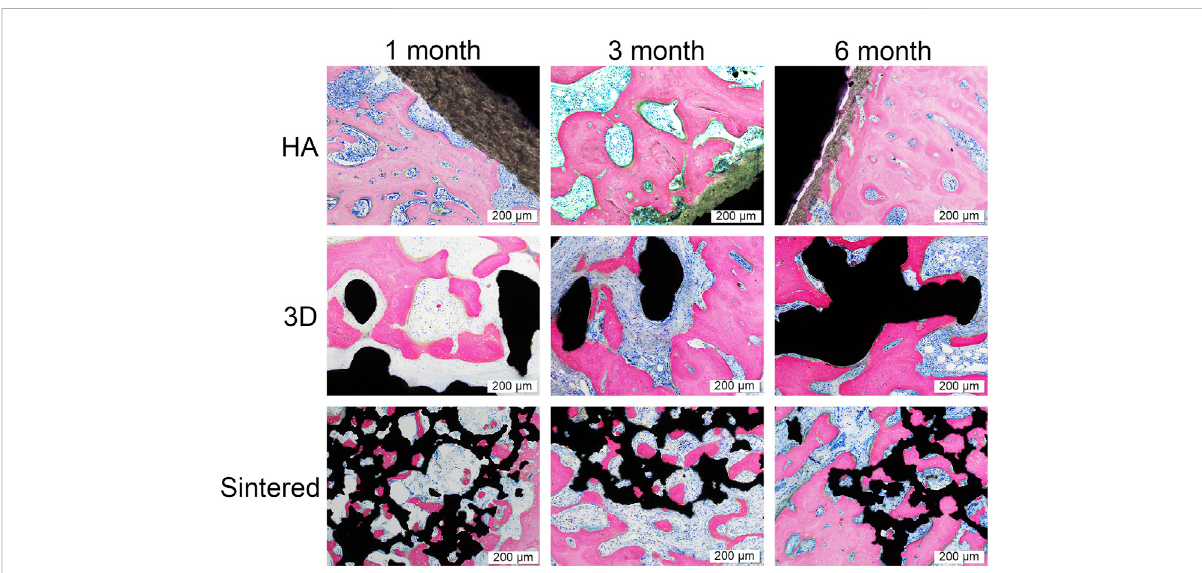
FIGURE 9 Pathological images of the three materials at 1, 3, and 6 months. Black in the picture represents the titanium alloy metal and the bone tissue is stained by rosy red. The scale was 200 μ m. Inthe HA group, there was aprogressive decrease in HAcoating resorption and aprogressive increasein peripheralbonetissuewithtime.Atmonth1,boththe3DandsinteredgroupsshowedmoreosseointegrationthantheHAgroup.Thesinteredgroup has more bone ingrowth into the porous structure in the sintered group than in the 3D group because of the more bionic 3D structure of the sintered group, and the bone tissue was better integrated with the sintered porous structure. As time increased, more bone tissue was observed surrounding the titanium cup in all three groups.